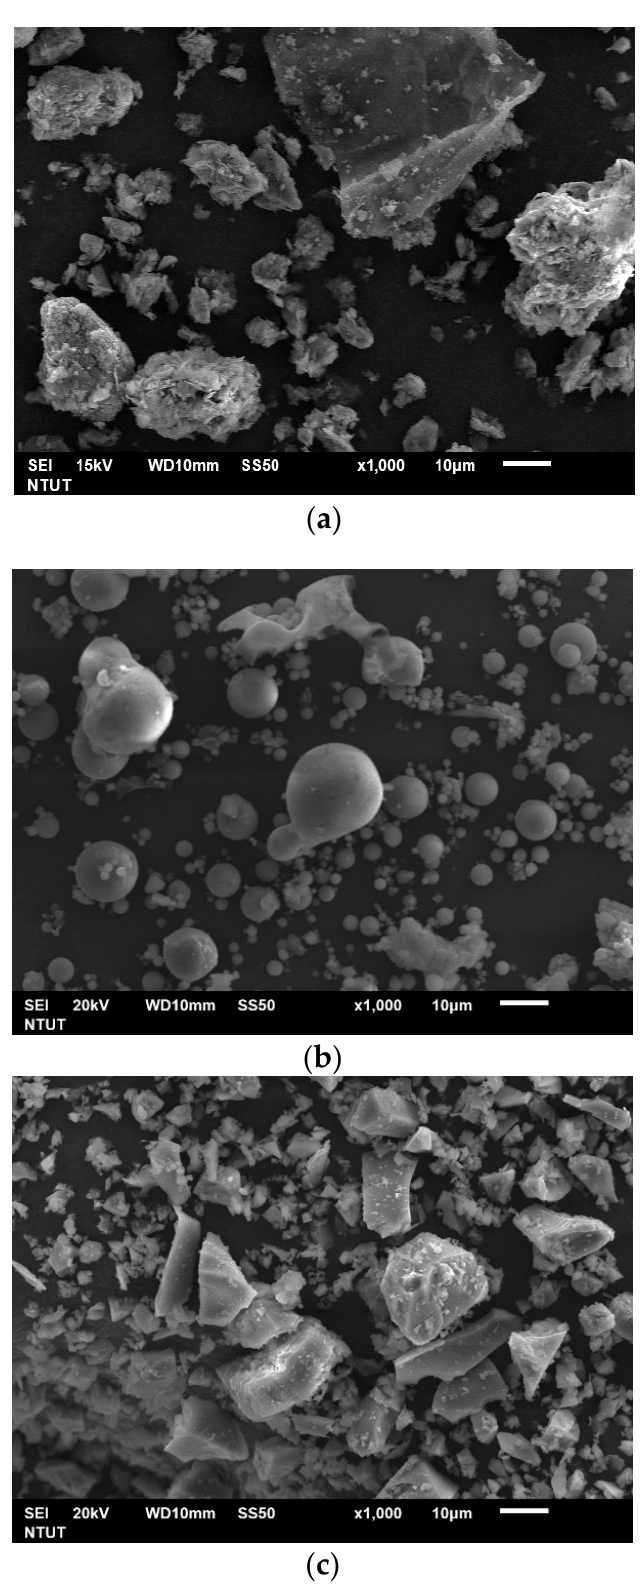
Figure 2. The XRD spectrum of Aggregate Sludge, Fly Ash, and Ground Granulated Blast Furnace Slag.